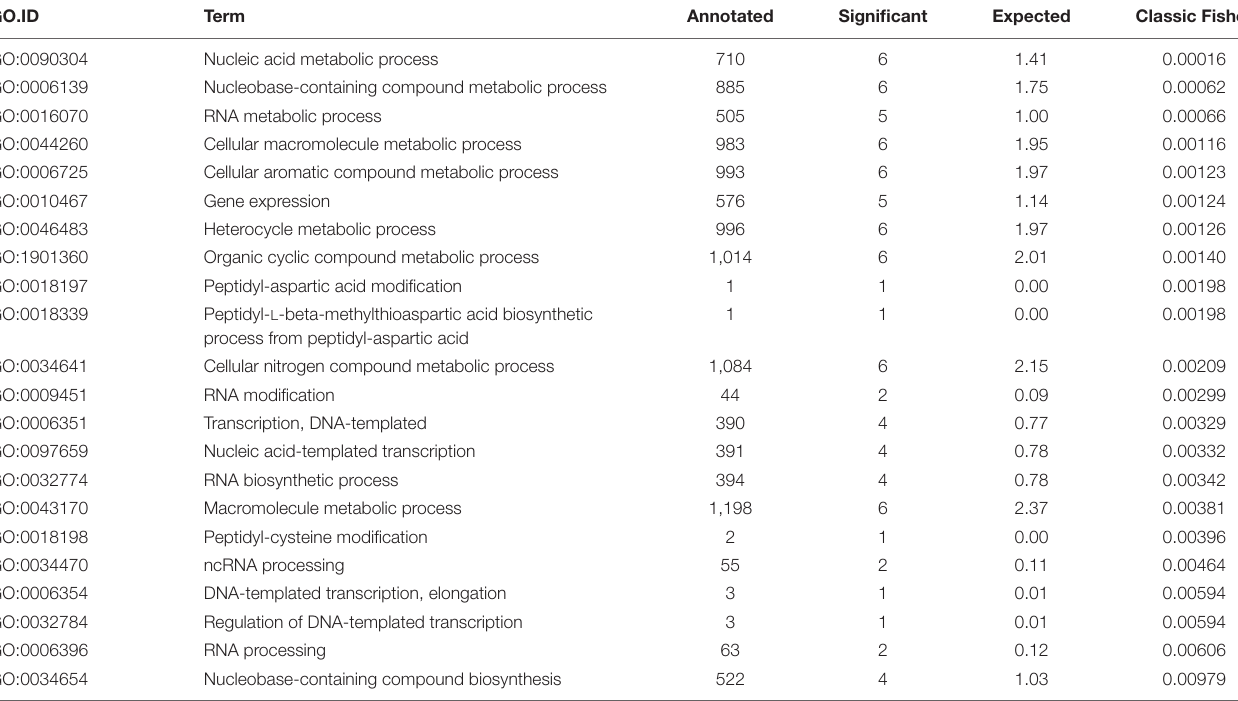
TABLE 5 | Biological process (BP) gene ontology (GO) enrichment results.